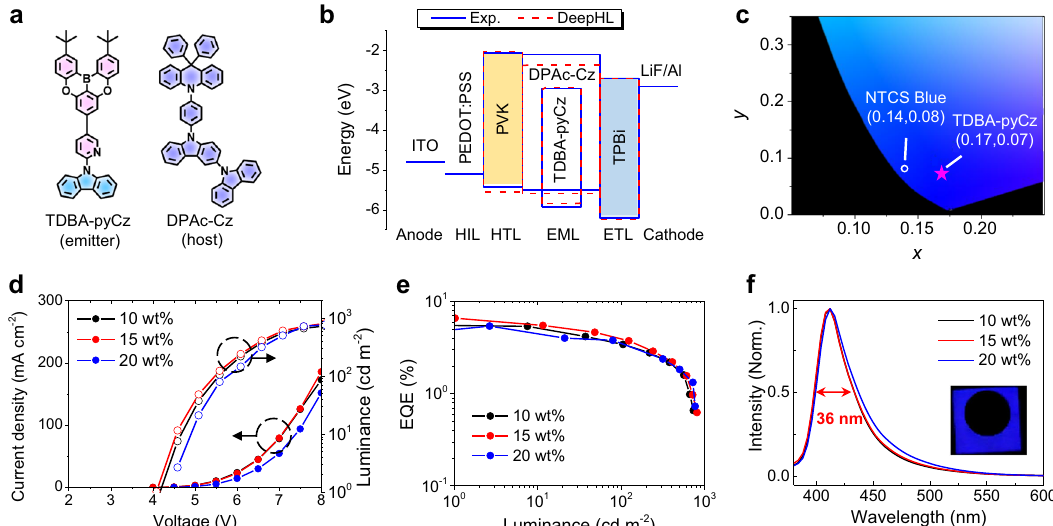
Fig. 5 Deep-blue fl uorescent OLED device with TDBA-pyCz and DPAc-Cz developed by DL-assisted virtual screening. a Molecular structures of DPAc-Cz (host) and TDBA-pyCz (emitter). b Device structure. c CIE 1931 chromaticity diagram. d Current density ( J ) – Voltage ( V ) – Luminance ( L ) curves. e EQE – Luminance ( L ) curves. f EL spectra at different doping concentrations of emitters at a luminance of 500 cd m − 2 . A photograph of the device emission is shown in the inset.